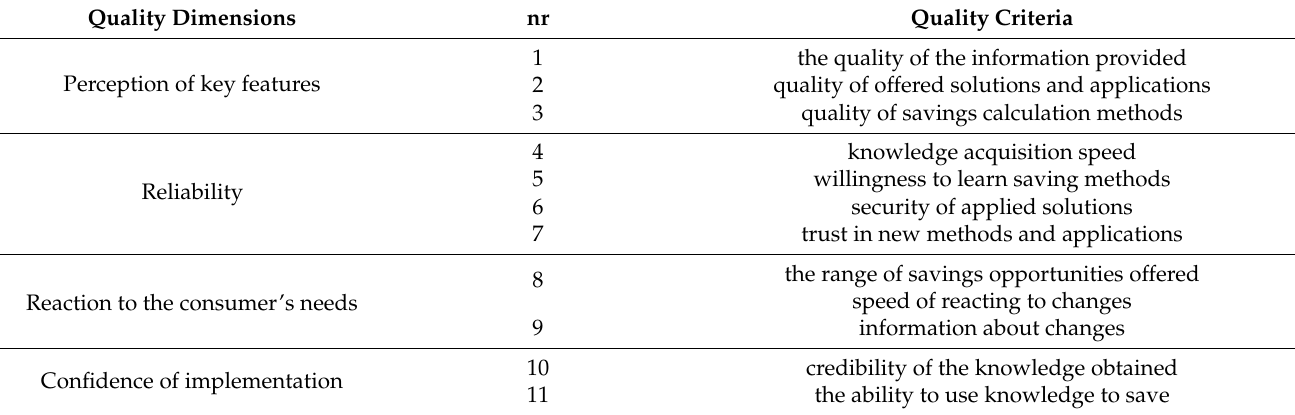
Table 5. SERVPERF analysis for energy saving behavior.